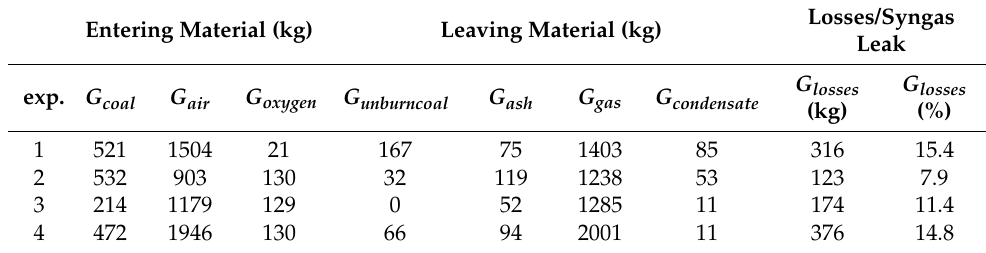
Table 2. Material balance for four